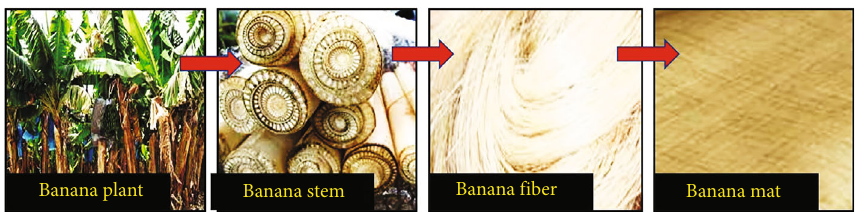
Figure 1: Banana fi bre extraction from banana plant.